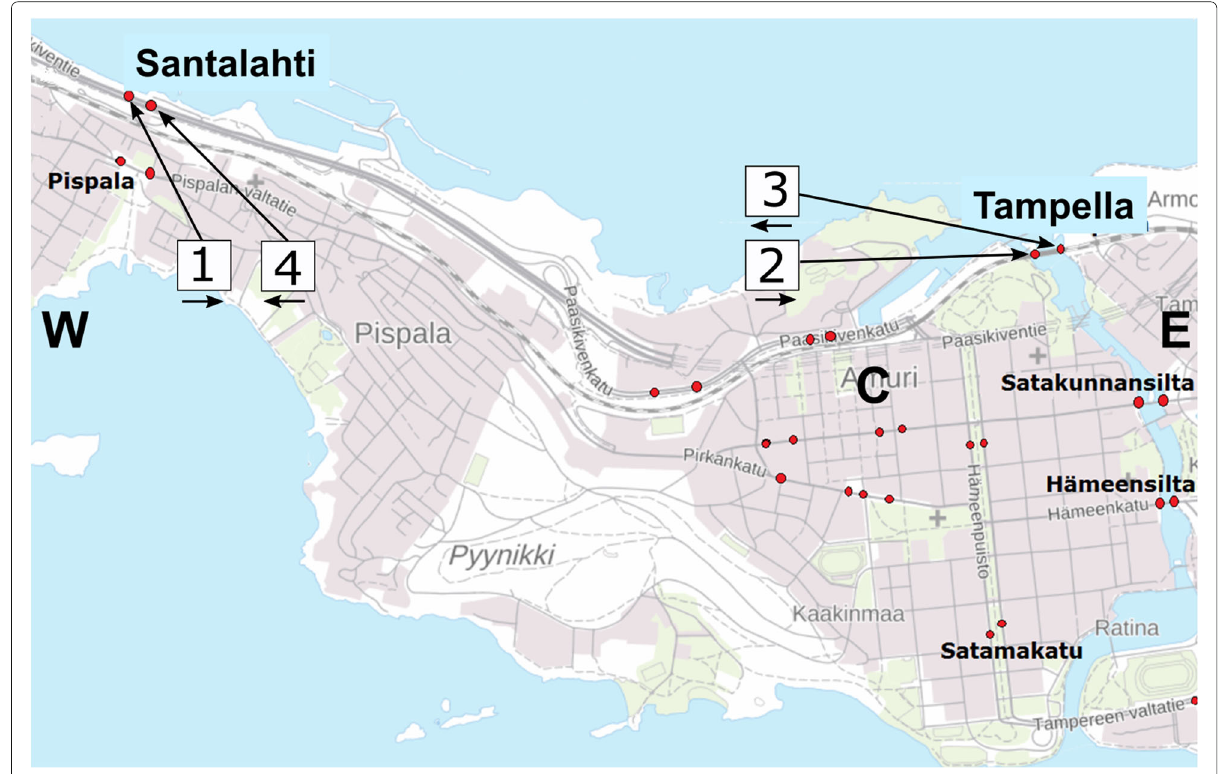
Fig. 5 Illustration of inductive loop measurement points in the city of Tampere. This research utilises locations Santalahti and Tampella and our measurement points are denoted as in Fig 1. The city centre, denoted by C, is located at southwest of Tampella